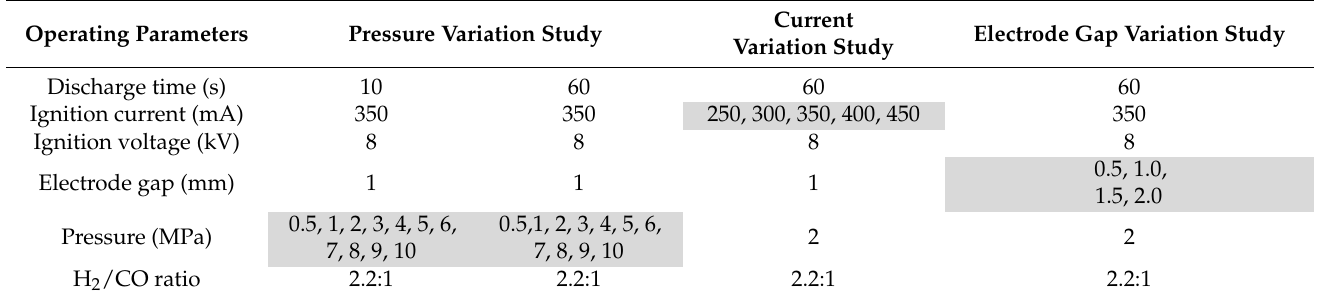
Table 1. List of operating conditions used in pure plasma and plasma-catalytic FTS.